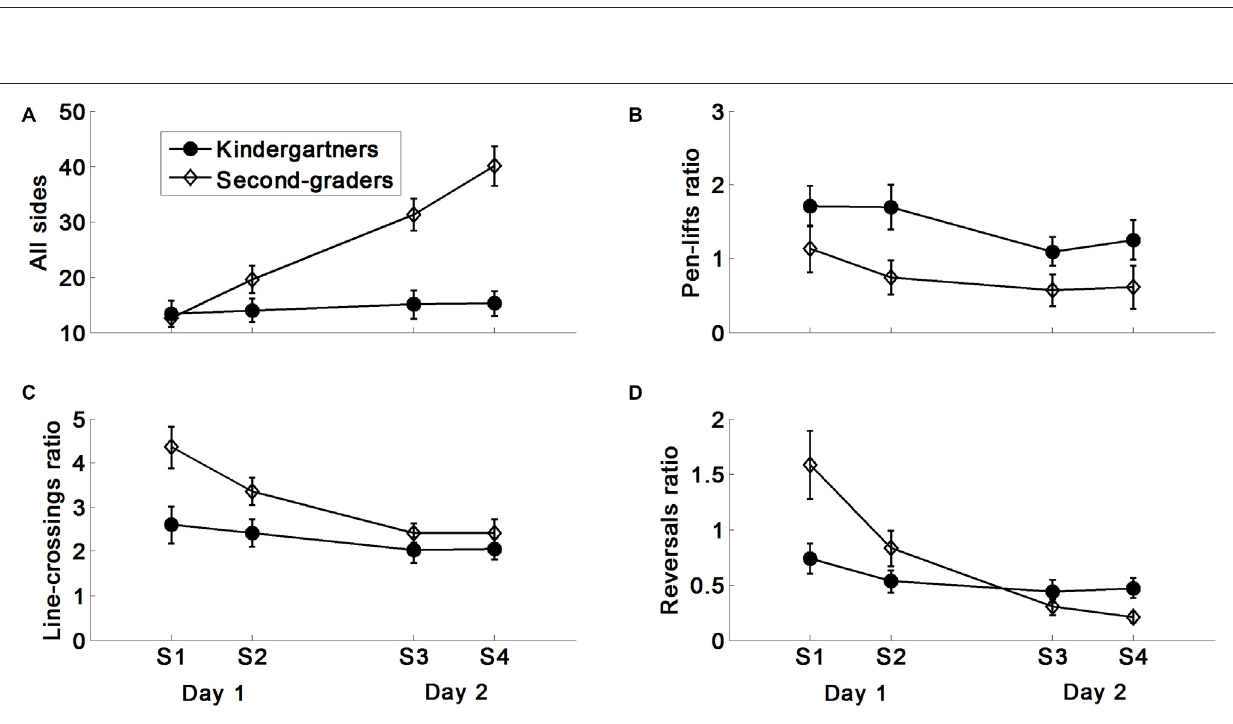
Frontiers in Human Neuroscience |